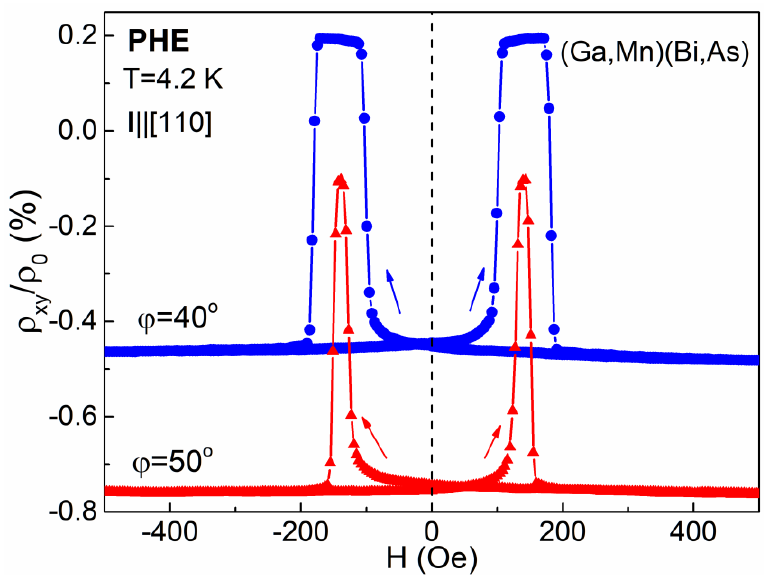
Figure 4. Same as in Figure 2 but measured for the sweeping magnetic field applied at the ϕ angle values of 40° and 50°. The curves are vertically offset for clarity.